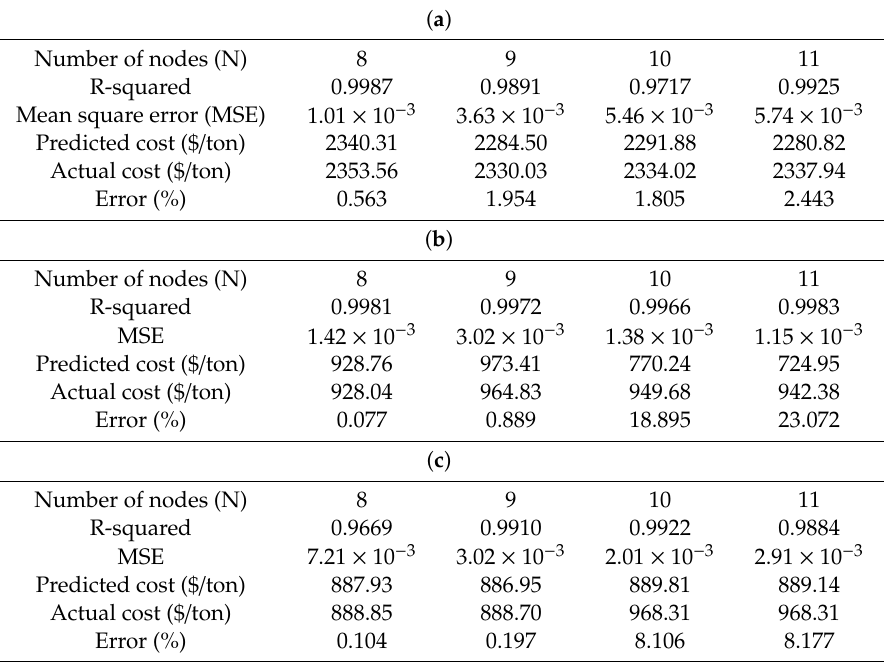
Table 2. ( a ) Results of fitting data with artificial neural networks for configuration I: once-through reactor methanol production; ( b ) Results of fitting data with artificial neural networks for configuration II: methanol production with a recycle; ( c ) Results of fitting data with artificial neural networks for configuration III: methanol production with two reactors in series.